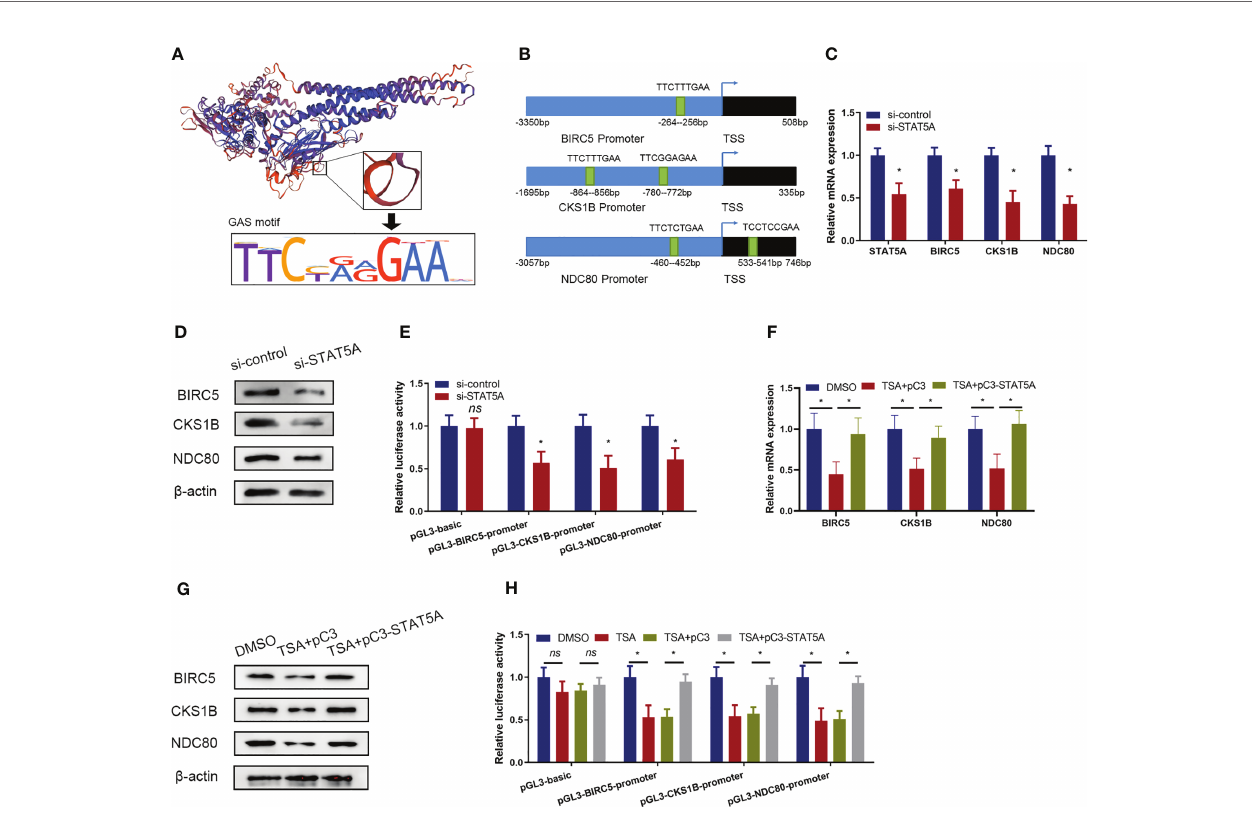
FIGURE 4 | TSA suppressed BIRC5 , CKS1B , and NDC80 transcription via STAT5A. (A) Schematic representation of DNA binding motif of STAT5A. (B) Predicted binding sites from BIRC5 , CKS1B , and NDC80 promoter regions for STAT5A. (C, D) HUVECs were transfected with si-control or si-STAT5A. BIRC5 , CKS1B , and NDC80 expressions were assessed by qRT-PCR (C) and Western blotting assay (D) . (E) BIRC5 , CKS1B , and NDC80 promoter plasmids [regions: − 3,350 to 508 ( BIRC5 ), − 1,695 to 335 ( CKS1B ), and − 3,057 to 746 ( NDC80 )] were co-transfected with si-STAT5A or si-control into HUVECs. HUVECs were then subjected to luciferase assays. (F, G) HUVECs were treated with DMSO or TSA, transfected with pC3 or pC3-STAT5A, and then were subjected to qRT-PCR analysis (F) and Western blotting analysis (G) to examine BIRC5 , CKS1B , and NDC80 expressions. (H) HUVECs were transfected with different BIRC5 , CKS1B , and NDC80 promoter plasmids, treated with DMSO or TSA, transfected with pC3 or pC3-STAT5A, and subjected to luciferase assays. * P < 0.05 vs. the control group. ns, not signi fi